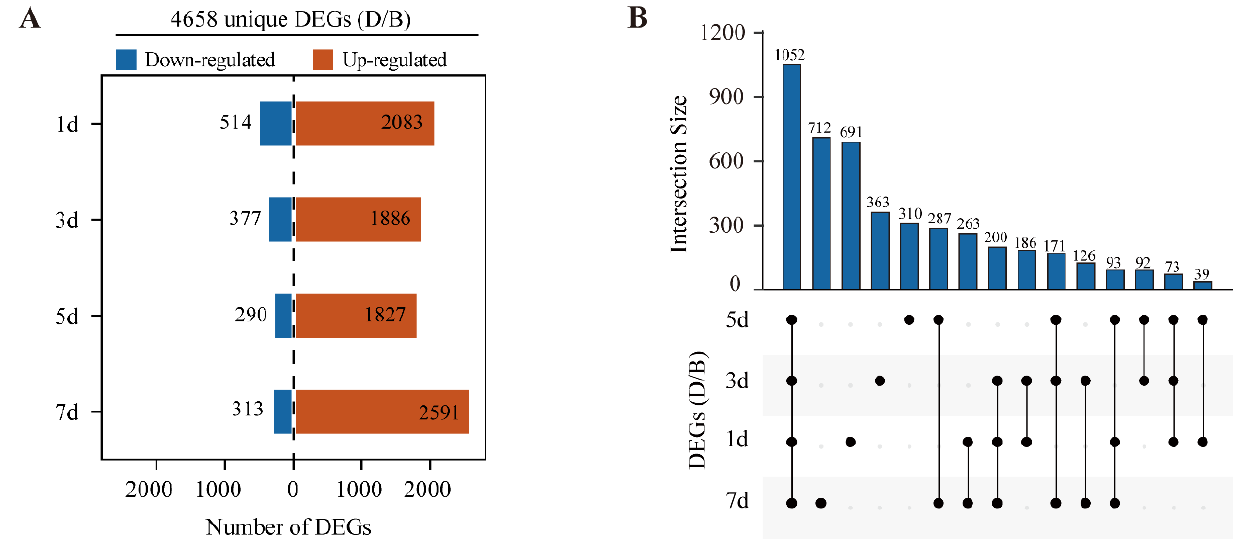
Figure 3. Differential gene expression analysis. ( A ) Counts of DEGs. ( B ) Upset plot showing the intersection of DEGs across all timepoints.